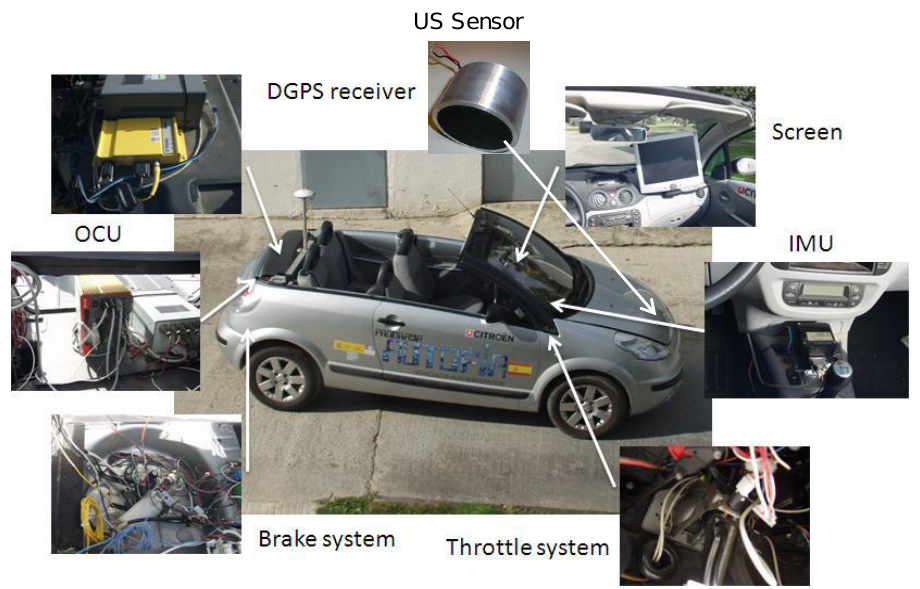
Figure 8. Experimental